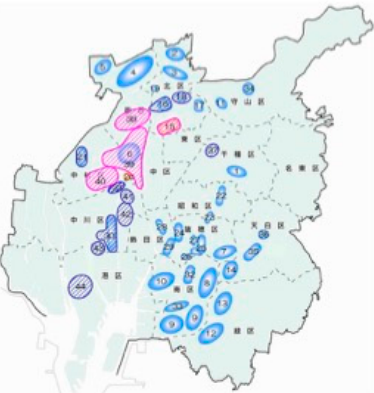
Figure 8. Urban flood management plan in Nagoya City (Progress as at the end of 2015)